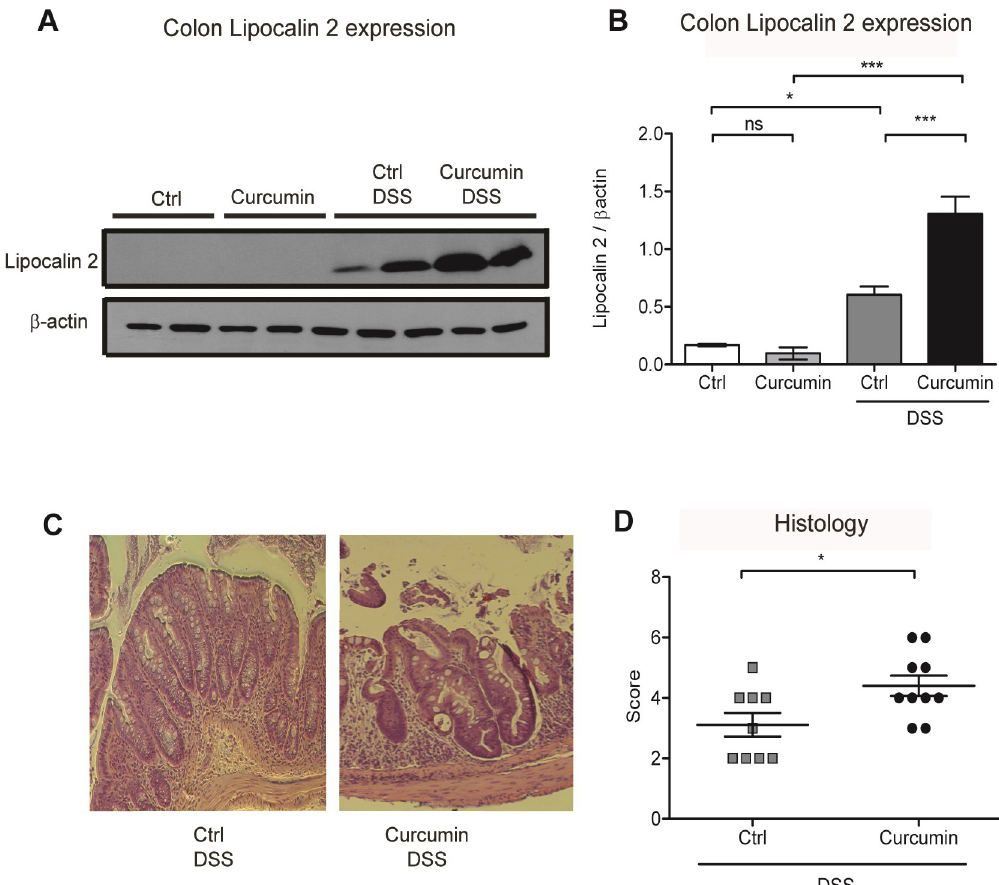
Fig 3. Curcumin supplementation in DSS-treated mice enhances inflammation in the colon. (A) Representative western blot of colon protein extracts probed with antibodies against lipocalin 2 and β -actin. Each lane represents an individual mouse. (B) Graphic depicting densitometric quantification of western blots from three independent experiments. Data are presented as mean ± SEM. (C) Representative hematoxylin and eosin staining of mouse colon histological sections. (D) Graphic depicting quantification of colonic histology scores. Statistical analysis was performed by two-tailed Student’s t -test. � P < 0.05, �� P < 0.01, ��� P < 0.001; ns = not significant; n = 8 mice per group.